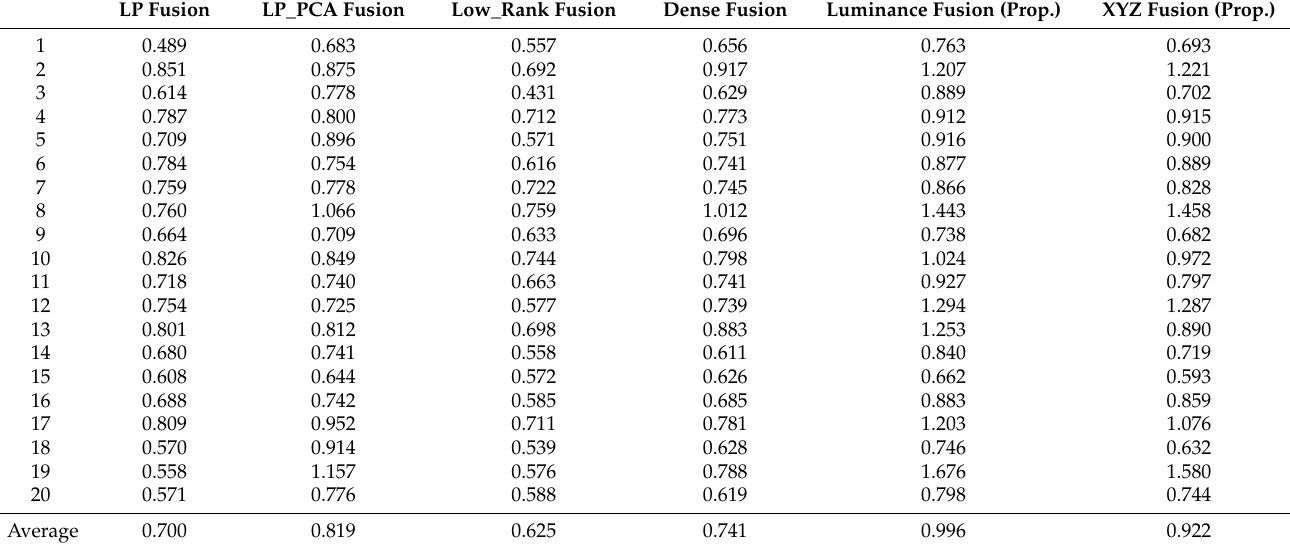
Table 4. Comparison of the VIFF